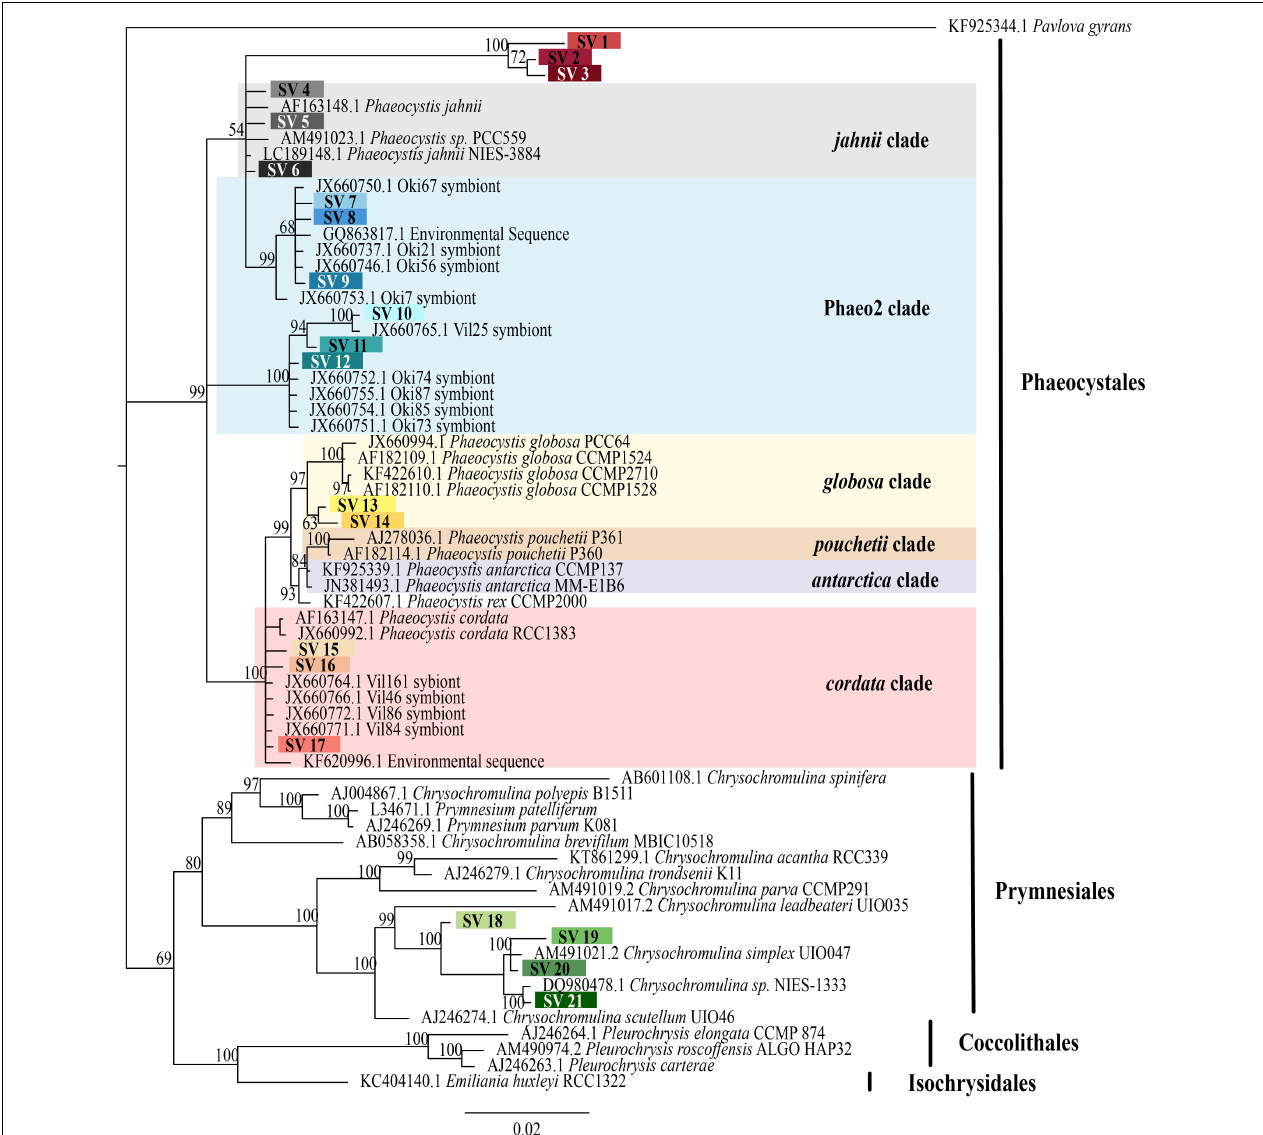
FIGURE 2 | Phylogenetic placement of symbiotic SVs identified from acantharian hosts. The phylogenetic tree was built from a MUSCLE v3.8.31 alignment of 21 symbiotic SVs and GenBank reference sequences representing the 5 haptophyte orders with MrBayes v3.2.7. The symbiotic SVs are highlighted to match the legend in Figure 1 . Phaeocystis clades are color coded and include the Phaeo2 clade, which is an uncultured clade identified from symbiotic sequences from acantharians collected near Okinawa (Decelle et al., 2012b). Values associated with nodes are posterior probabilities as a percent after 100,000 generations (average SD of split frequencies = 0.019). The scale bar indicates 0.02 changes expected per